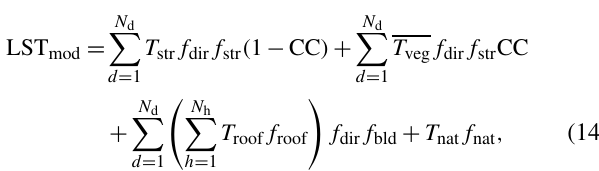
Table 3. Overview of observation sites used for model evaluation. Figure 3b shows the location of the sites. T is air temperature, q specific humidity, u wind speed, Q H sensible heat flux, and Q E latent heat flux. Name Variable a Type Height f urb L can LCZ BKLI T , q , u , Q H , Q E Flux tower 38m 0.79 1.50 Compact mid-rise (2) BFEL T Surface 2m 0.98 1.03 Compact mid-rise (2) BSJO T Surface 2m 0.85 SLFR T Surface 2m Large low-rise (8) BBIN T Surface 2m < 0 . 10 0.00 Rural low plants c (D) BLER T , q , u Surface 2 / 10m < 0 . 10 0.00 Rural low plants